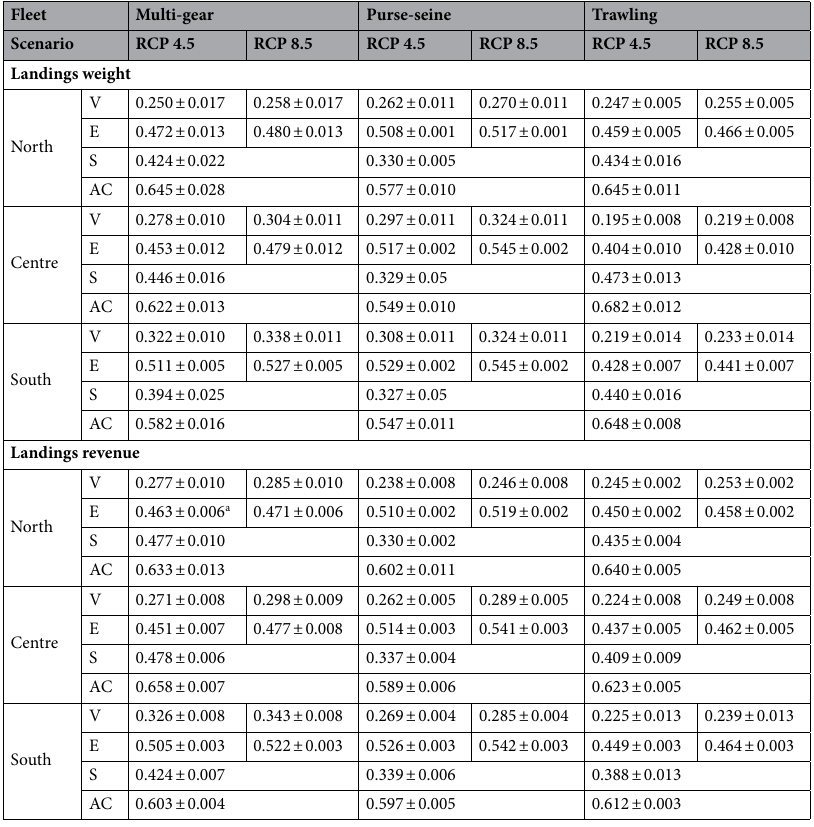
These differences in species contribution to EVL (kg) of purse-seine fleets explained the higher dissimilarity found between north area compared to both centre and south areas (see Supplementary Table S3 online). For trawling, high dissimilarities in the species contributing to vulnerability were observed between north and centre, and north and south areas (Supplementary Table S4 online). The main species that contributed to the dissimilarity between areas for EVL (Kg) were T. trachurus in the north, M. poutassou in the centre and south areas, followed by P. longirostris and N. norvegicus (Fig. 4c). In the south, O. vulgaris was the species most contributed to the dissimilarity with the centre area (Supplementary Table S4 online). When analysing the components of the EVL (kg) (sensitivity, exposure and adaptive capacity), we found that the fleet with the highest sensitivity was trawling (Supplementary Table S5 online), whereas purse-seine had the lowest sensitivity values, in the three areas (Fig. 5a; Supplementary Table S6 online). For exposure, an inverse pattern was observed when compared to sensitivity. Purse-seine landings had the highest values of exposure in all areas, followed by multi-gear and trawling (Fig. 5a). The ecological adaptive capacity was higher in trawling landings in the centre and south, whereas in the north multi-gear and trawling landings presented similar adap- tive capacity. In the three areas, purse-seine landings had the lowest adaptive capacity (Fig. 5a). EVL–landings revenue. The ecological vulnerability of fisheries in revenue (EVL (€) ) differed from the EVL (kg) . We observed an increase in the importance of high price species, such as O. vulgaris in multi-gear, S. pilchardus in purse-seine and P.longirostris or Nephrops norvegicus in trawling (Fig. 4d). The EVL (€) of multi-gear was higher in the south, while the purse-seine showed similar EVL (€) in the central and south areas. Trawling did not present differences between areas (Fig. 4b). In the north and south, multi-gear had the highest EVL (€) , while trawling had a significantly lower EVL (€) in the centre and south areas (Fig. 4b, Supplementary Fig. S4 online). For multi-gear, an increase in the contribution of O. vulgaris in terms of economic revenue was observed in comparison to the contribution of landing weights (Fig. 4c,d). This is due to the higher average price of O. vulgaris (4.33 €·Kg −1 ) compared to S. pilchardus (1.57 €·Kg −1 ) and T. trachurus (1.60 €·Kg −1 ). Dissimilarity in EVL (€) was higher between the north and south area (Supplementary Table S3 online). A. carbo contributed the most to the dissimilarity between areas followed by O. vulgaris , which contributed to the dissimilarity of the south area (Fig. 4d).